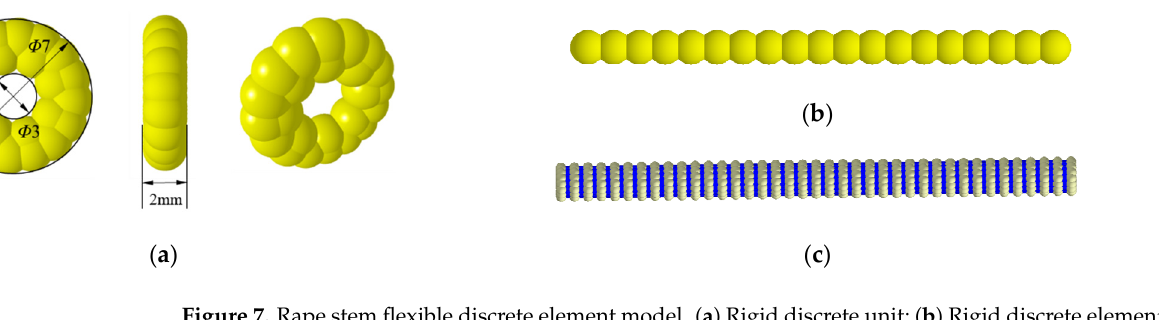
( b ) Figure 8. Rape stem three-point bending test: ( a ) Physics test; ( b ) Simulation test. 2.4.3. Bonding Parameter Calibration In the Hertz–Mindlin with Bonding contact model, the key parameters include nor- mal stiffness per unit area, shear stiffness per unit area, critical normal stress, critical shear stress, and bonded radius. Referring to the vine materials and existing studies on